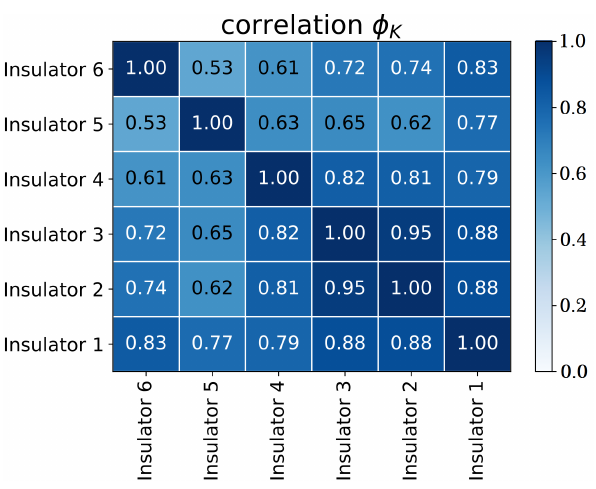
Figure 2. Correlation of the samples based on their leakage current values.